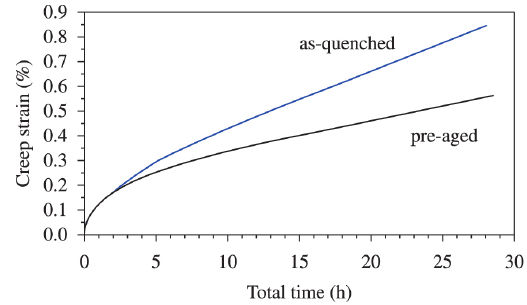
Figure 4. Comparison of creep curves for an as-quenched and a pre-aged AA7010 at 150°C [1] .